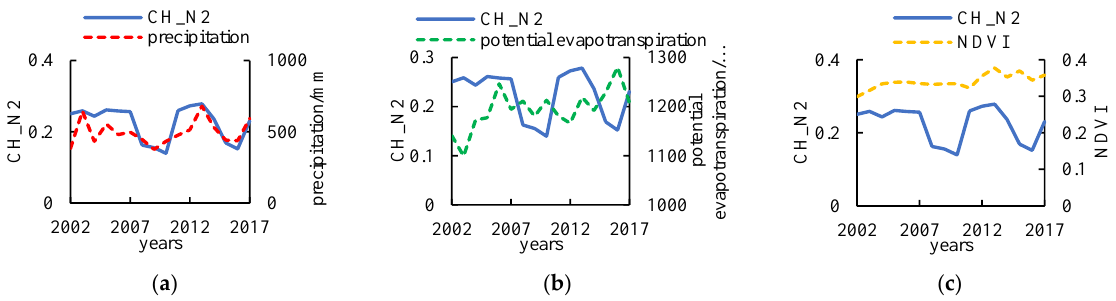
Figure 9. Time-varying process of CH_N2 to basin precipitation, potential evapotranspiration and NDVI. ( a ) Precipitation, ( b ) potential evapotranspiration, ( c ) NDVI.